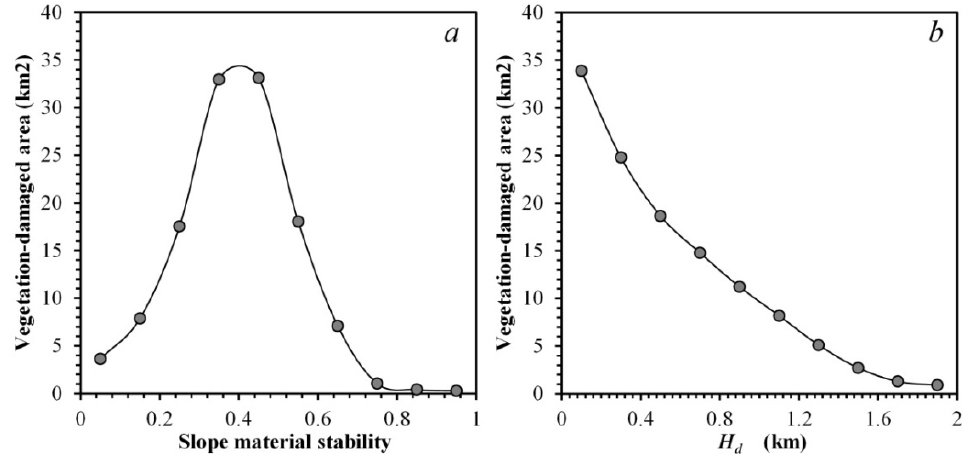
Figure 8. Vegetation-damaged distributions with the slope material stability ( a ) and after the horizontal distance to river streams, H